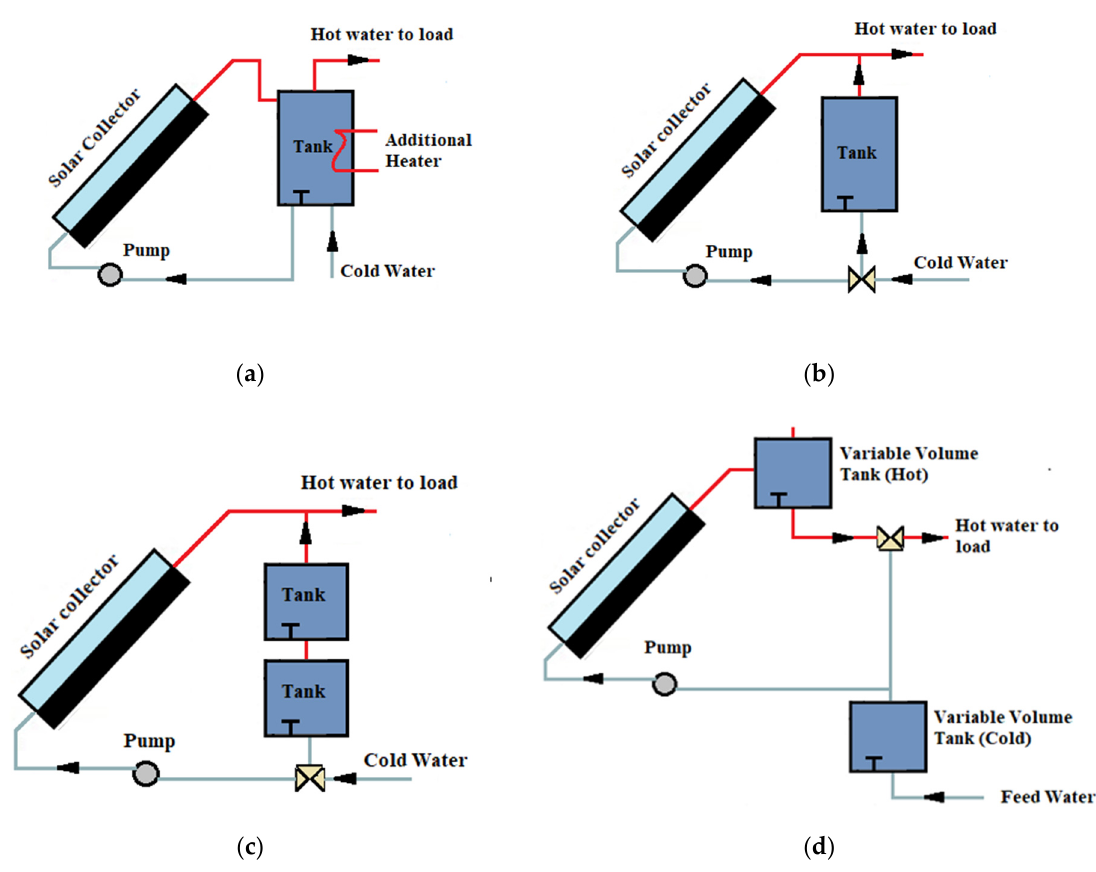
Figure 4. Four configurations of direct solar hot water systems: ( a ) Four-pipe arrangements, ( b ) Two-pipe arrangements, ( c ) Multiple tank storage, ( d ) Variable-Volume storage. Adapted and modified from Ref. [42], Copyright (2018), with permission from Elsevier.